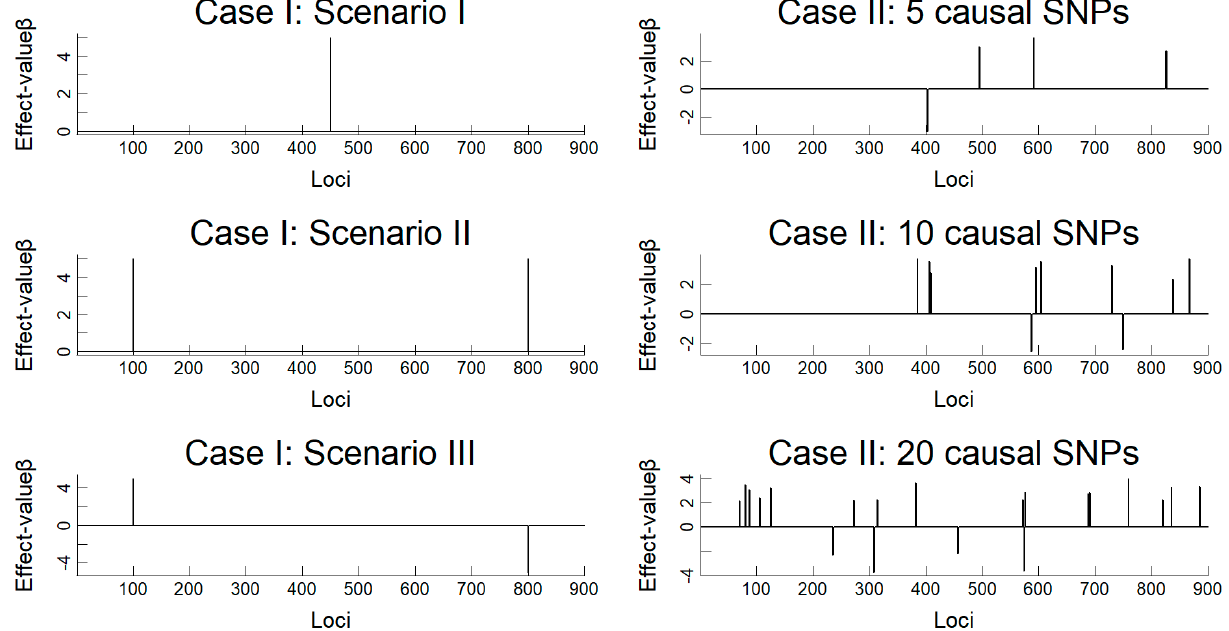
Figure 1. The simulated gene regions of Case I and Case II. X-axis (Loci) represents the SNP loci in the gene region, Y-axis (Effect-value β ) represents the effective value of each SNP loci. The proportion of negative effect in causal SNPs and the effect size c in effect model is 20% and 3, respectively. Table 1 illustrates the power of three methods of Case II under the significant level